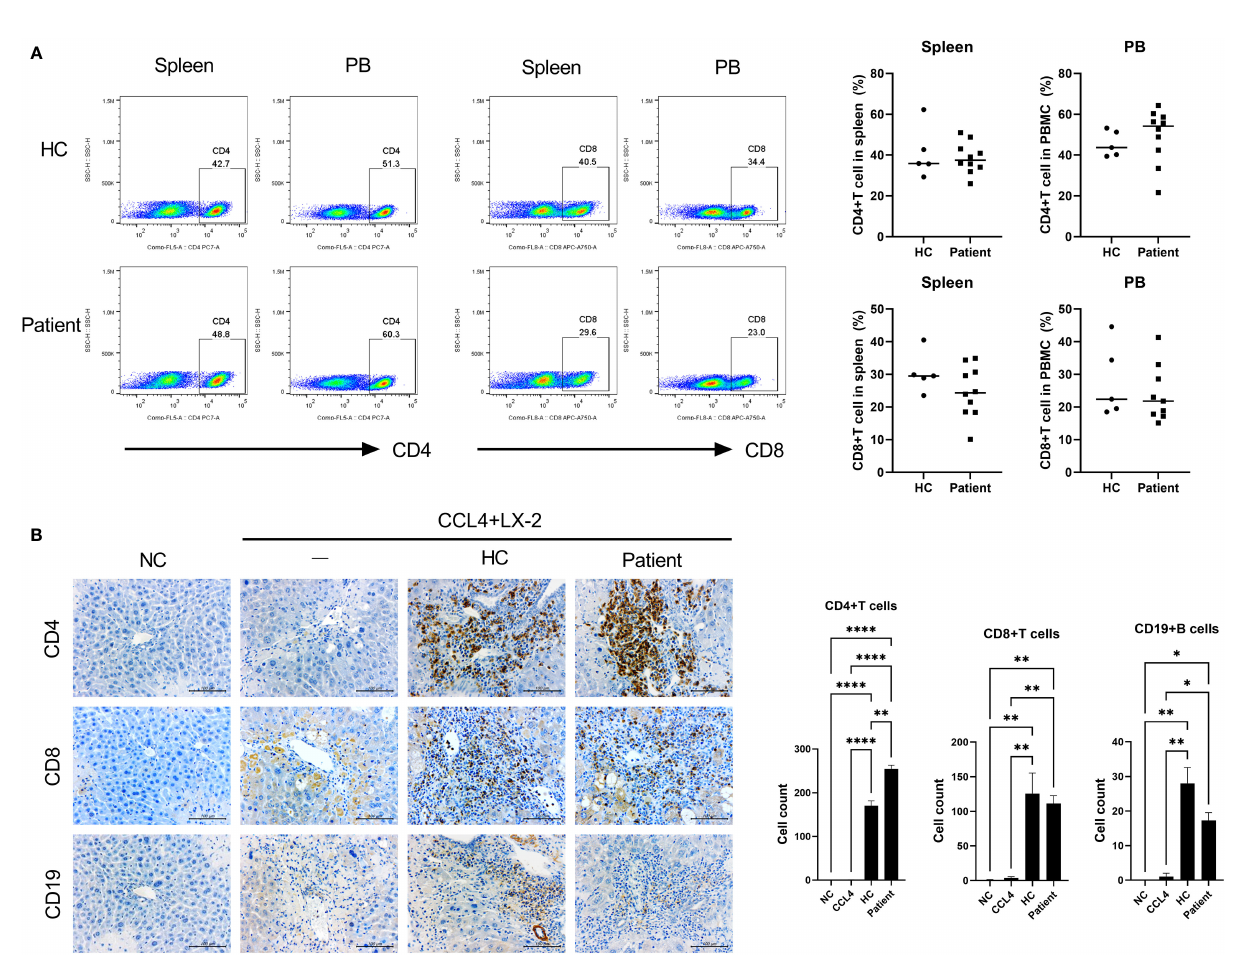
FIGURE 1 | Generation of patient-derived avatar models in LT patients. (A) To develop the humanized mouse model from patient-derived PBMC, PBMCs were isolated from whole-blood samples obtained from LT patients or HCs. Freshly isolated PBMCs (5 × 10 6 ) were injected intravenously into NSG mice. At 1 day after intravenously transplanting hHSCs to engraft, mice were injected with CCl 4 twice weekly at various time points as indicated. At 49 days after induction of humanized mice, recipient spleens and peripheral blood were collected to analyze the engraftment levels of human CD4 + and CD8 + T-cell populations in the spleen and blood by using fl ow cytometry. (B) Histologic analysis of in fi ltration of human CD4 + and CD8 + T cells and CD19 + B cells in mouse liver tissue by immunohistochemistry staining. Data were obtained from three independent experiments, and values are represented as the mean ± SEM. LT, liver transplantation; PBMC, peripheral blood mononuclear cell; NC, negative control; HC, healthy control; hHSC, human hepatic stellate cell. * P < 0.05; ** P < 0.01; **** P <